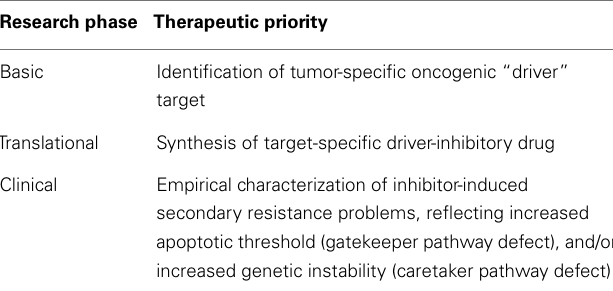
Table 1 | Sequence of steps in cancer drug